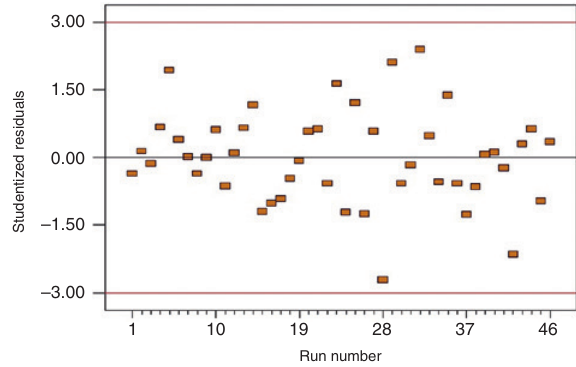
Figure 7: Residual vs. run.